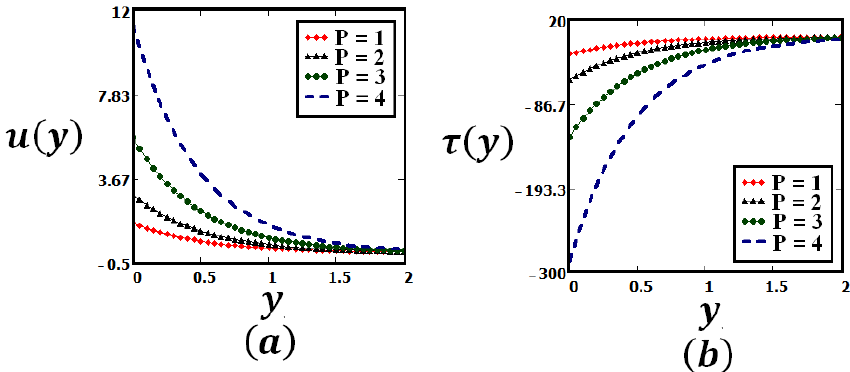
Figure 10: Profiles of the velocity field u ( y , t ) and the shear stress τ ( y , t ) for fractionalized Jeffrey fluid given by Eqs. (16) and (21), for A =